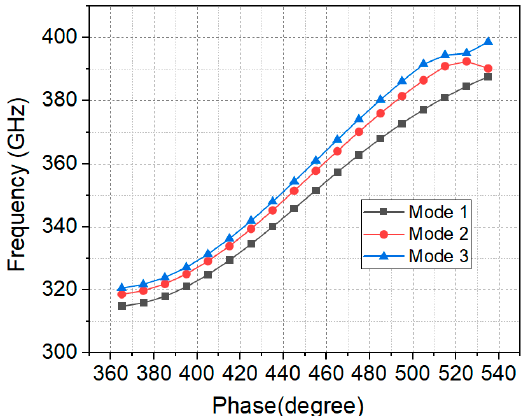
Figure 2. Dispersion curves of MBSC-SWG-SWS.